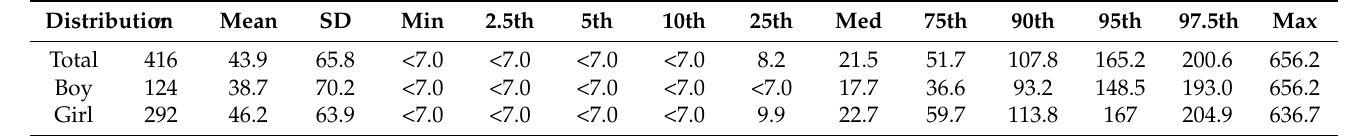
Table 2. Distribution of serum lipoprotein(a) in 416 Korean children and